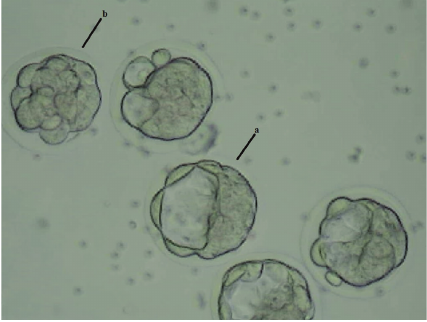
Figure 1: Grade 1 bovine blastocyst (a) and morula